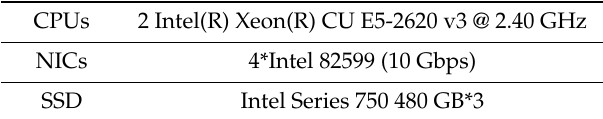
Table 2. Hardware configuration for experimental server. NICs: network interface cards; SSD: solid state disc.